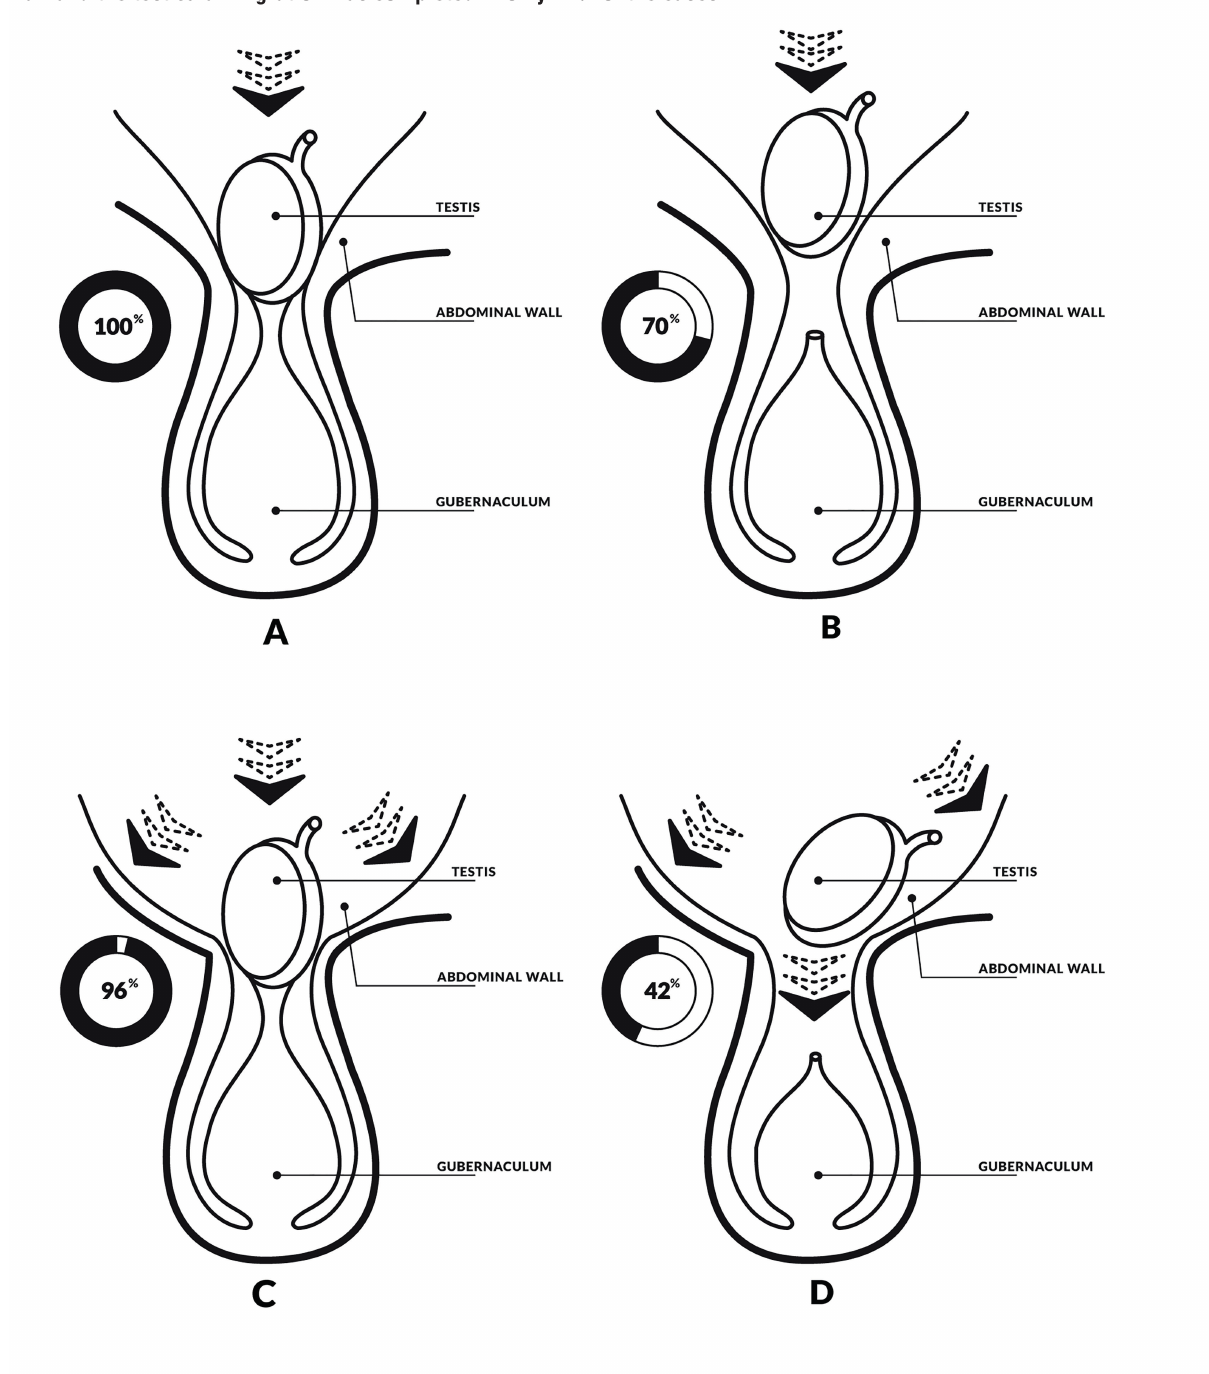
Figure 3 - Schematic drawing, based on experimental paper of Attah and Hutson (4) showing the importance of abdominal wall in testicular migration process. A) The abdominal wall and the gubernaculum were preserved and the testicular migration occurs in 100% of the cases in the experimental study. The arrowhead represents the intra-abdominal pression; B) The gubernaculum was sectioned and the testicular migration was completed in 70% of the cases in the experimental study; C) in the figure we can observe that authors created a defect in the anterior and the testicular migration was completed in 96% of the cases; and D) The authors performed a section in gubernaculum testis and created a defect in the abdominal wall and the testicular migration was completed in only 42% of the